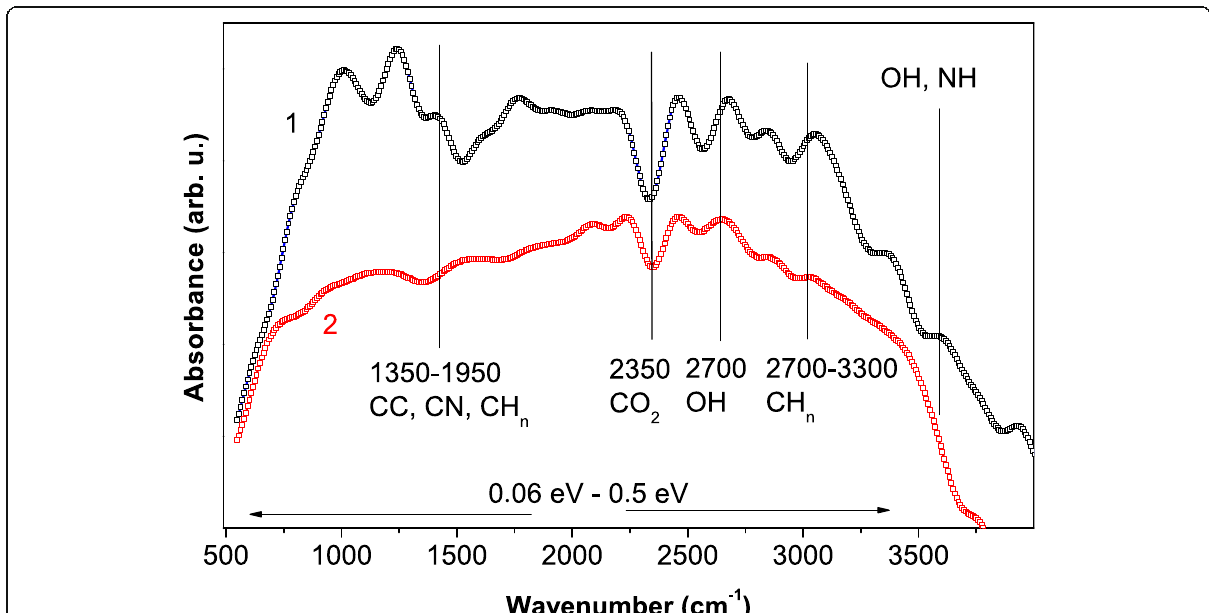
Fig. 3 FTIR spectra of bulk CZTS sample with (curve 1) and without (curve 2) RF treatment (13.56 MHz stimulated discharge H + plasma, t = 15 min, P = 0.8 W/cm 2 )